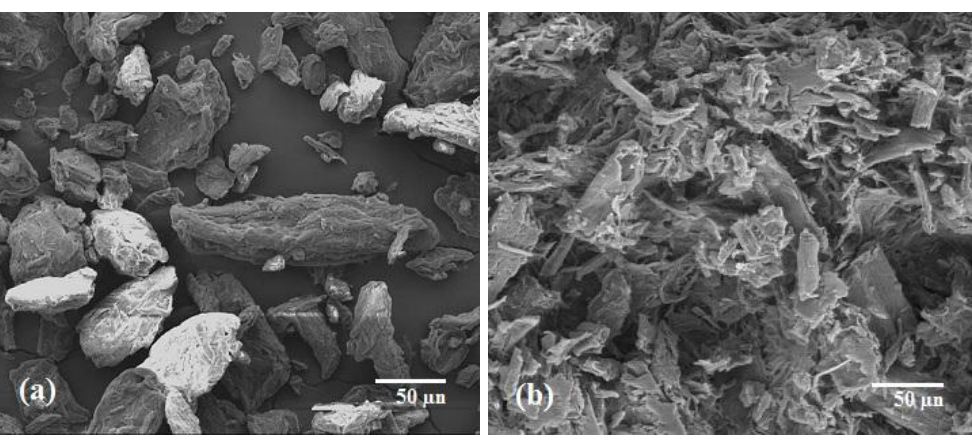
Figure 4. SEM images: ( a ) untreated MCC; and ( b ) acid hydrolyzed MCC in the presence of FeCl 3